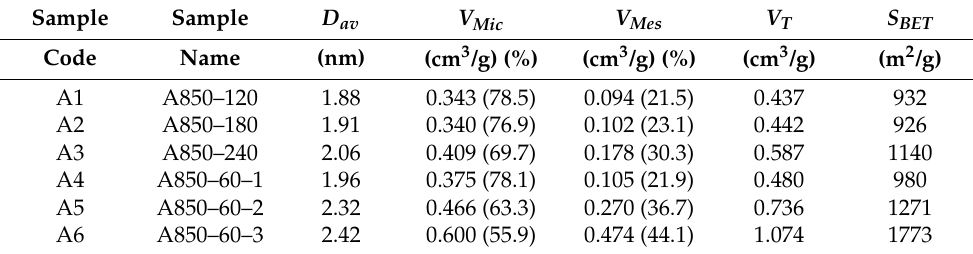
Table 2. Porous properties of prepared microporous- and mesoporous-activated carbons.